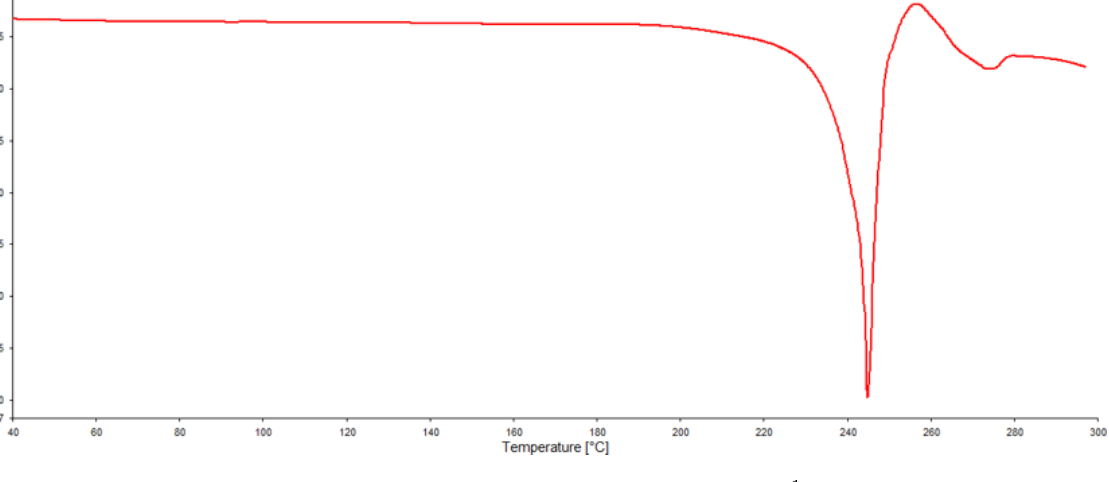
Figure 2 . DSC curve of Fen at a heating rate of 10 °C min − 1 . Figure 2. DSC curve of Fen at a heating rate of 10 ◦ C min − 1